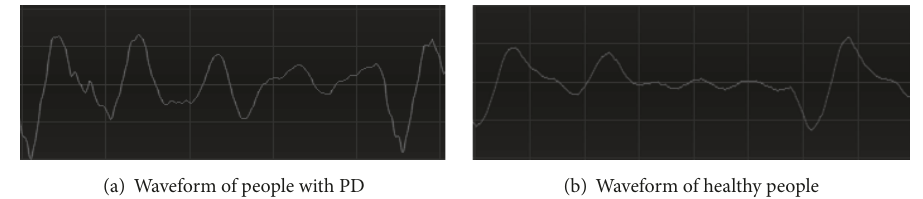
Figure 1: Waveform of voice records from Istanbul University [21, 22] ( 𝑥 -axis: time duration, 𝑦 -axis: amplitude of the